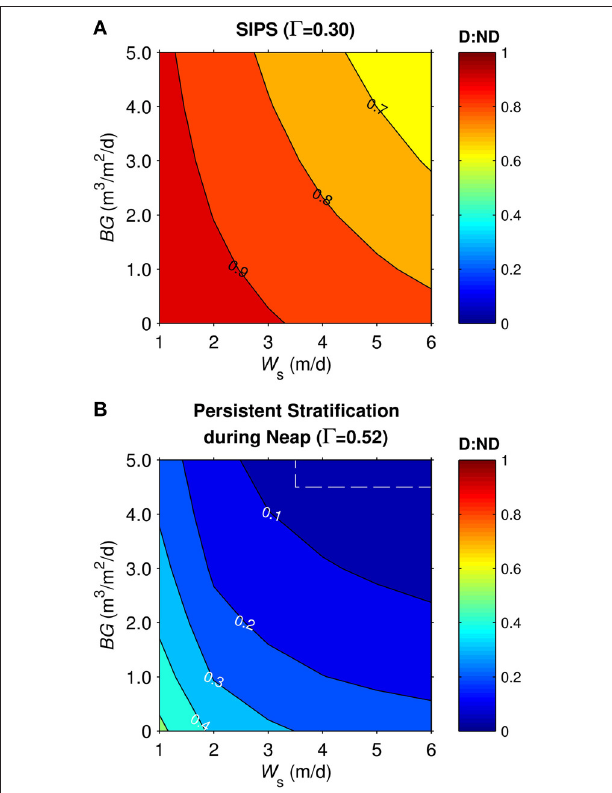
FIGURE 8 | Diatom:non-diatom ratios (D:ND) for generic channel. D:ND is based on computed diatom and non-diatom biomass in 10m deep channel at 7 simulation days and is shown for multiple combinations of benthic grazing rate ( BG ) and diatom sinking speed ( W s ). (A) generic channel SIPS hydrodynamic case, (B) generic channel neap-tide persistent stratification case. Values within dashed box were calculated from computed